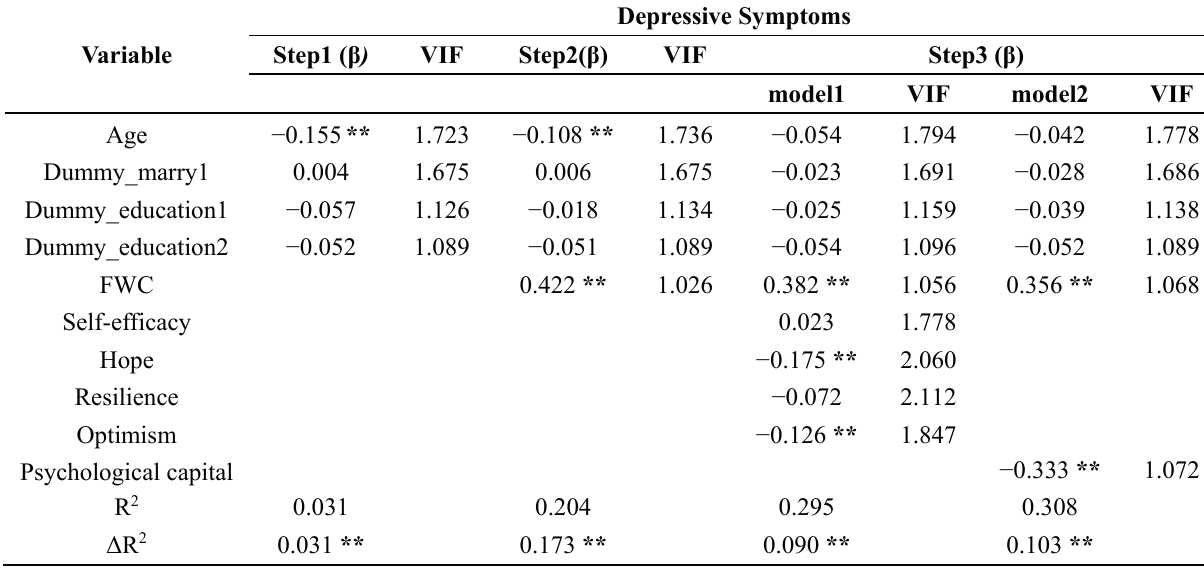
Table 12. Hierarchical linear regression analysis results of